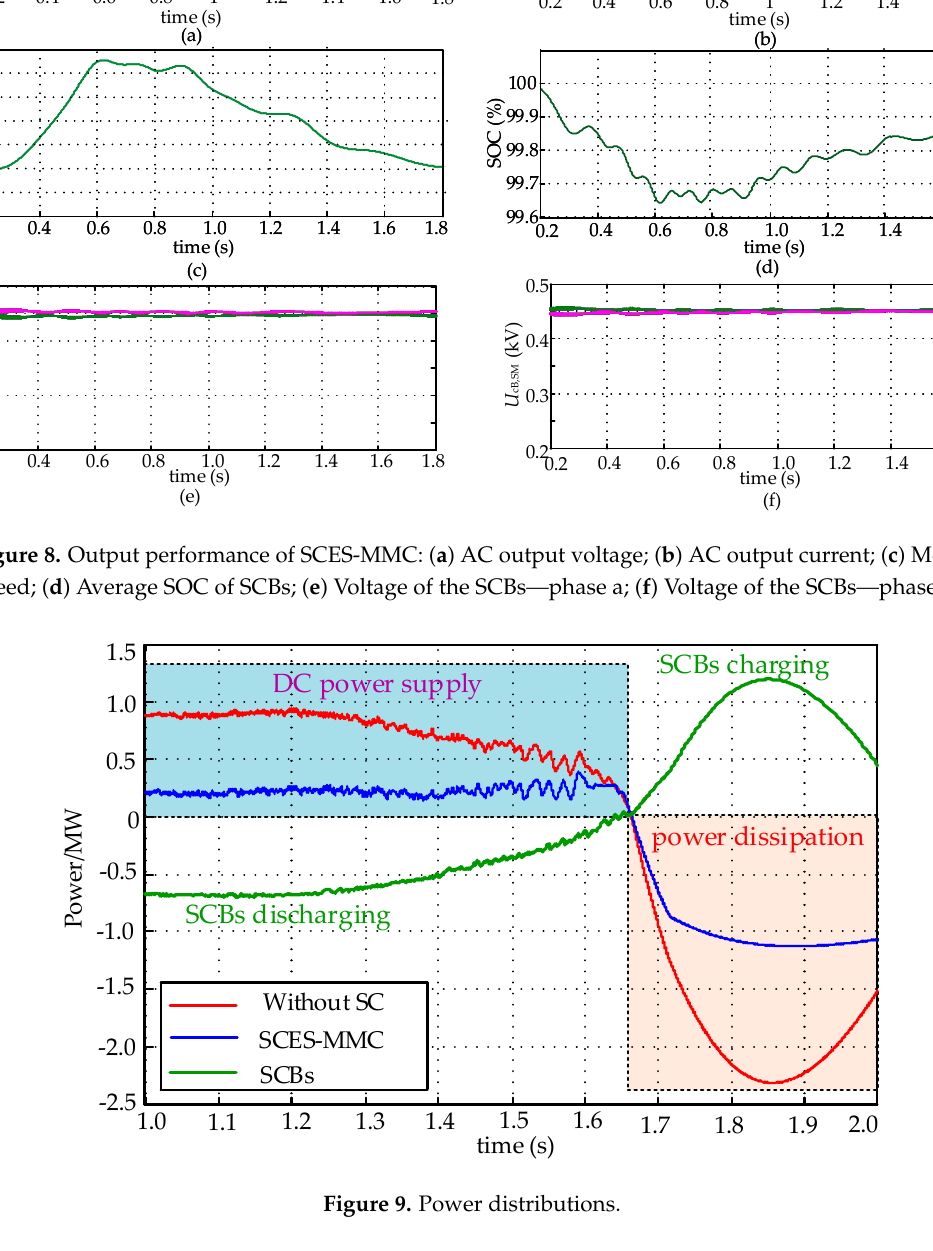
Figure 9. Power distributions.